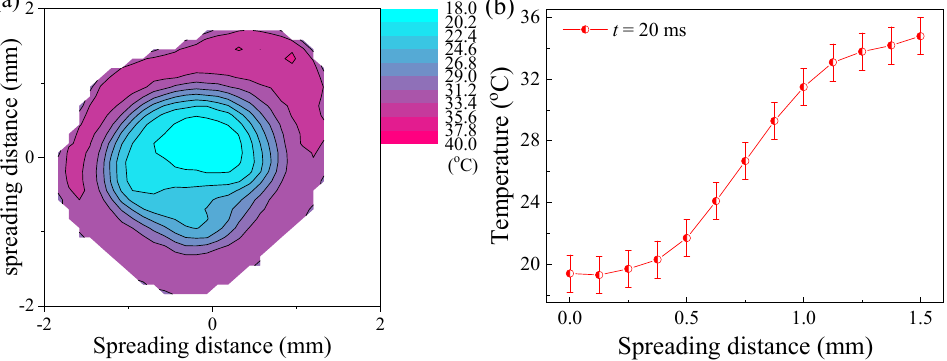
Figure 5. Temperature distribution of droplet impact on the hydrophilic copper surface at t = 20 ms. ( a ) Infrared image and ( b ) cold and hot temperature regions. Experimental conditions: W e = 7.6, T w = 40 °C. 0 represents the impact center.